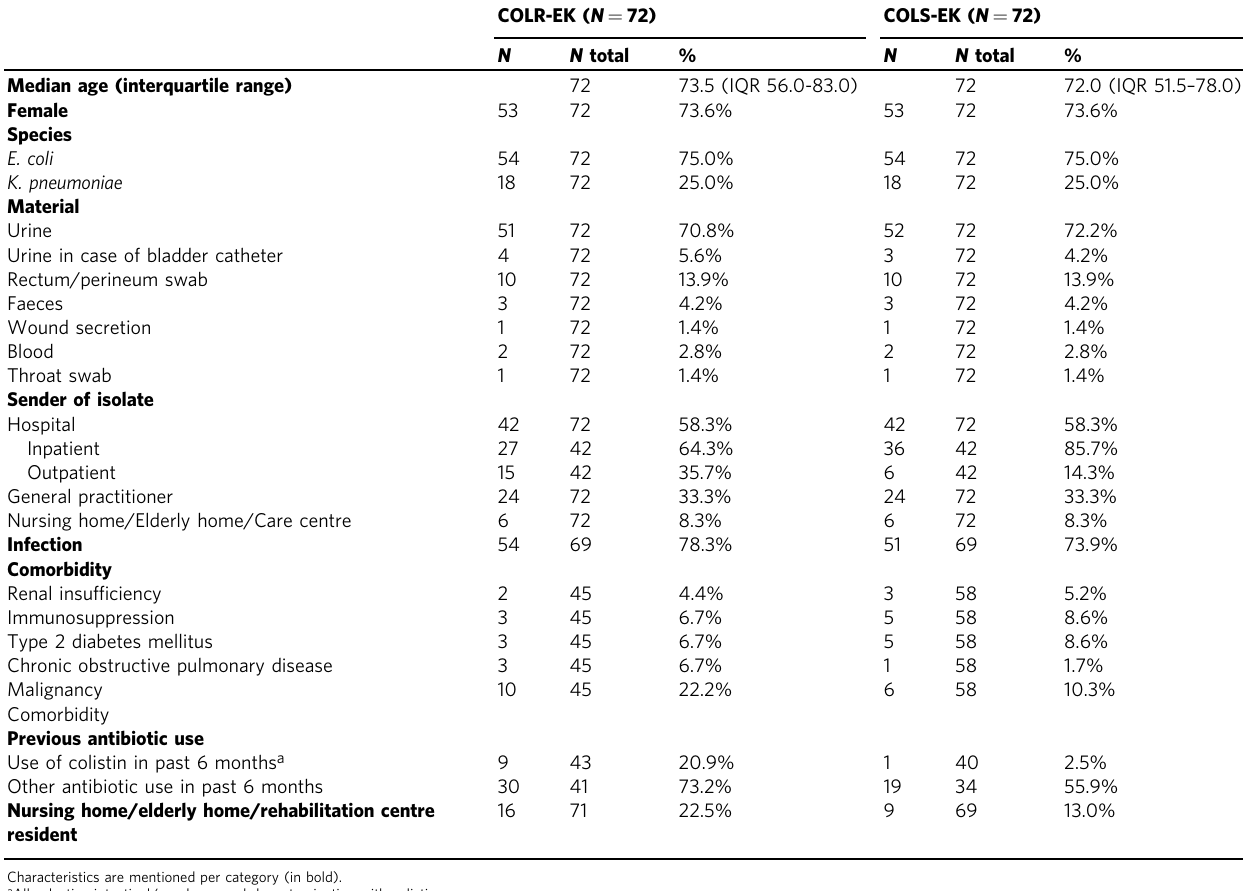
Table 1 Characteristics of patients carrying COLR-EK or COLS-EK isolates.